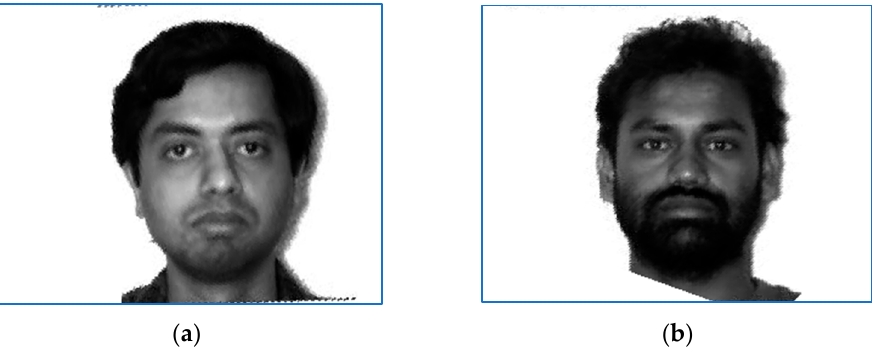
Figure 5 present the alignment results of Algorithm 2.